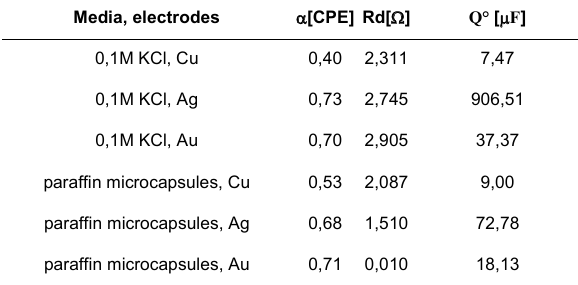
Table 2: Parameters determined by fitting the determined impedance of the double layer to the model of a CPE element in series with a